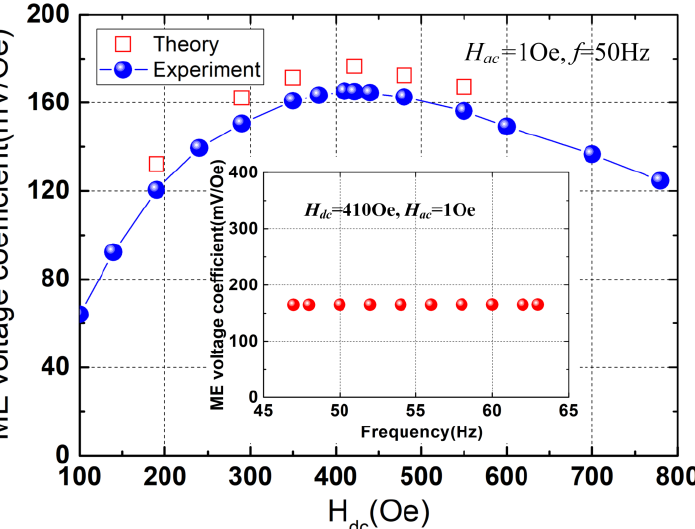
The ME voltage coefficient was measured for different bias magnetic fields ( H dc ) at the power-frequency of 50 Hz and an alternating magnetic field ( H ac ) of 1Oe, and the results are plotted in Figure 4. As shown in Figure 4, the ME voltage coefficient exhibits a nearly linear increase for H dc < 200 Oe and attains a maximum value of 165.2 mV/Oe at the optimal H dc of 410 Oe, which corresponds to the maximum magnetostriction of the Terfenol-D. The measured ME voltage coefficient is in good agreement with the calculated result (~176.6 mV/Oe). The ME voltage coefficient (165.2 mV/Oe) is larger than those of the traditional ME laminate composites using PZT [31–33]. For example, the ME voltage coefficient is 56 mV/Oe for the longitudinal-transverse (LT) mode [31] and is 86 mV/Oe for longitudinal magnetized/longitudinal polarized (L-L) mode [32]. The ME voltage coefficient near the power frequencies (50 Hz and 60 Hz) is shown in the inset of Figure 4, and a flat response is observed. The nearly linear response of the ME voltage coefficient to the bias magnetic field within the low-field range demonstrates the potential application prospect of the proposed device for use in DC magnetoelectric sensors.